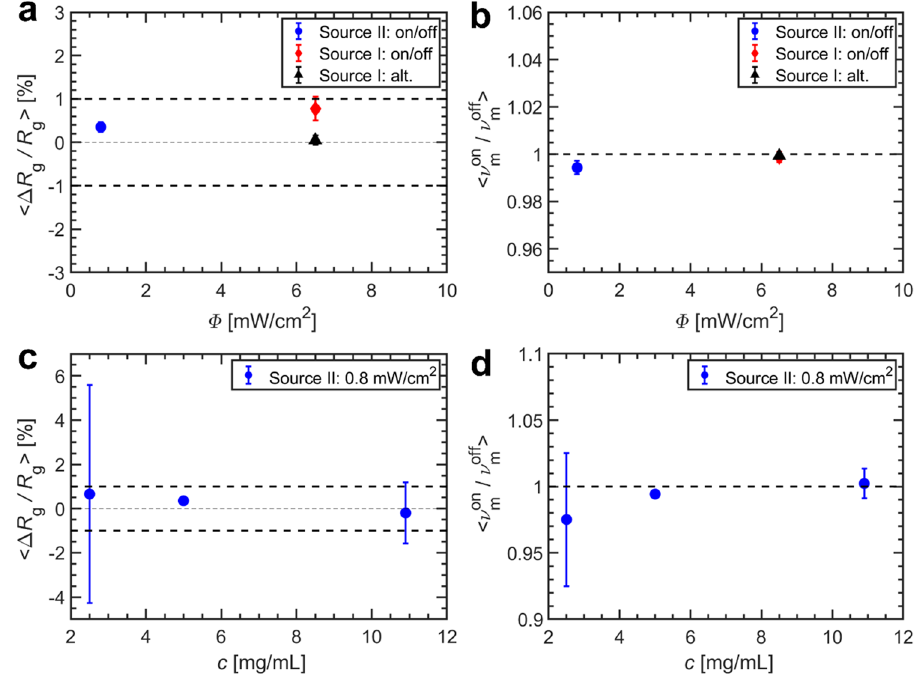
Figure 4. Structural parameters of BSA under THz-irradiation. ( a ) Average ΔR g /R g as a function of the nominal radiation power density Φ (for a protein concentration c ≈ 5 mg/mL). Deviations of ± 1% are marked by bold dashed lines. ( b ) Average monomer fraction ν on bold dashed lines ( c ) < ΔR g /R g > and ( d ) < ν on